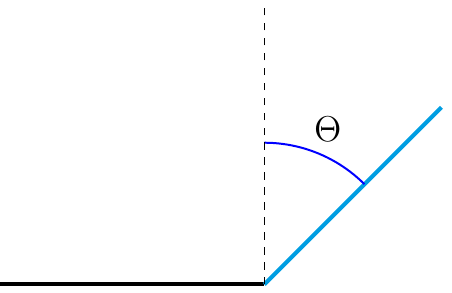
Figure 4. Geometry dual to the vacuum state of a BCFT on a half